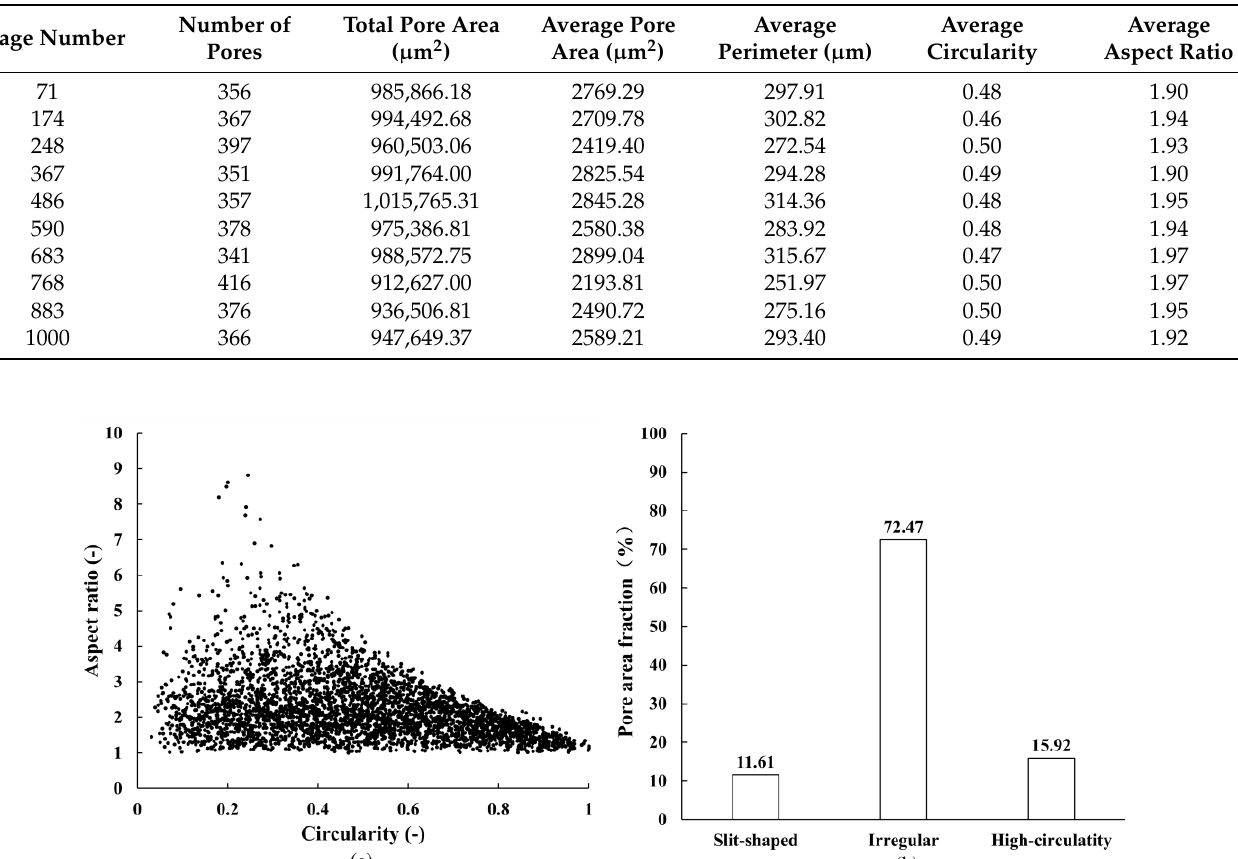
Table 2. Summary of the pore geometry parameters of the Berea Sandstone.